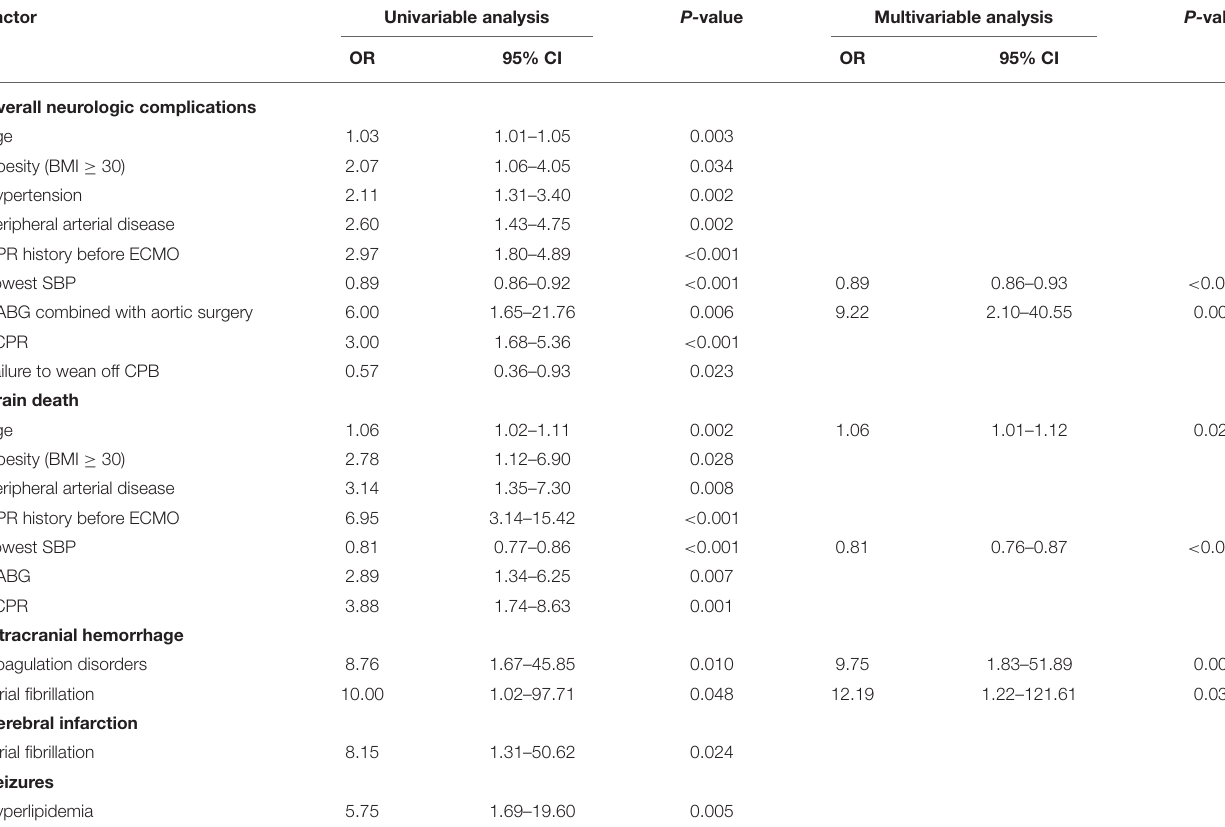
TABLE 3 | Univariable and multivariable analyses of factors associated with neurologic